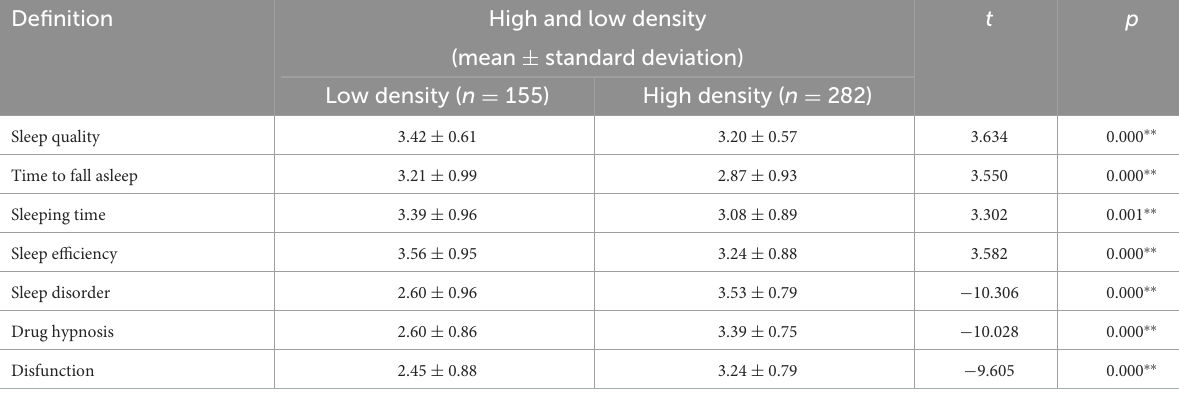
TABLE 3 Sleep status t -test analysis results under different residential densities.